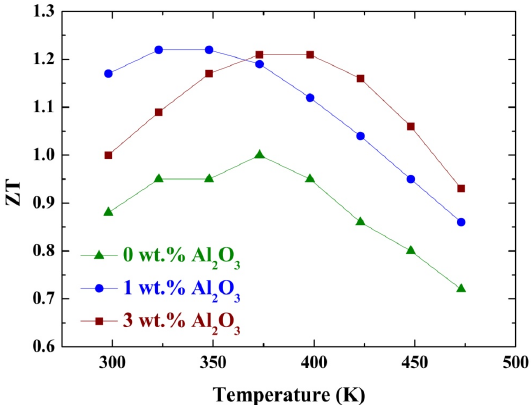
Figure 6. Variation of ZT as a function of temperature for γ -Al 2 O 3 /Bi 0.4 Sb 1.6 Te 3 bulk samples.